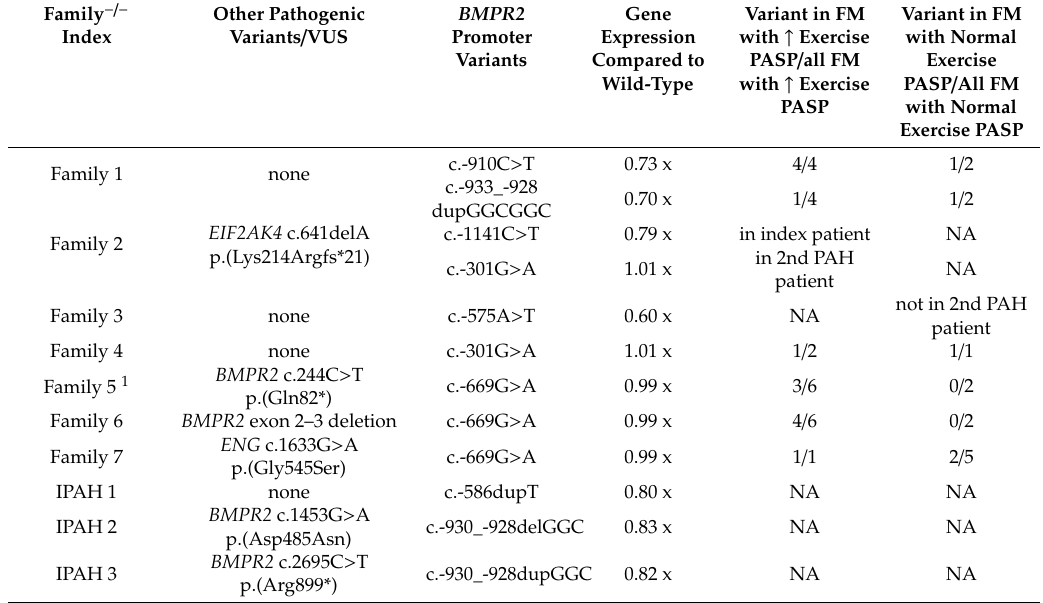
Table 3. BMPR2 promoter and further gene variants in I / HPAH